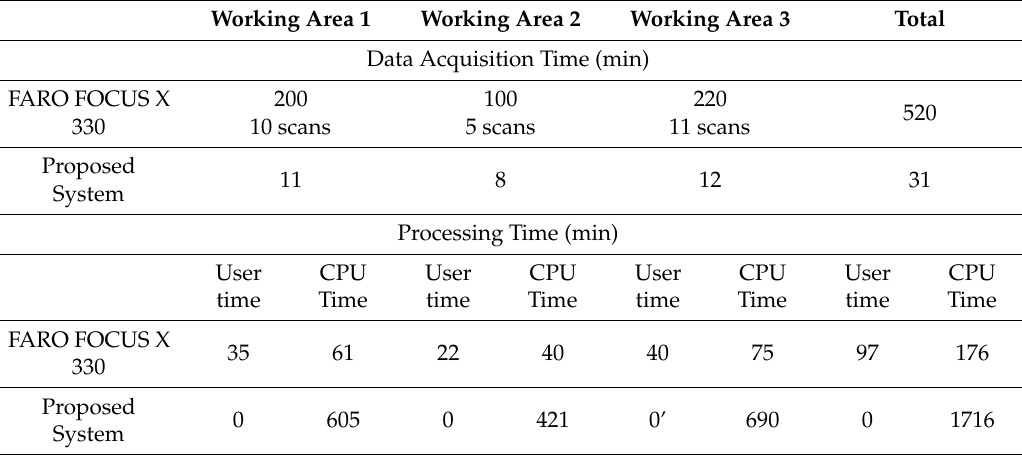
Table 2. Summary of total and partial times (working areas 1, 2, and 3) used in the acquisition and processing of data with the Faro Focus3D X 330 system and the proposed system.